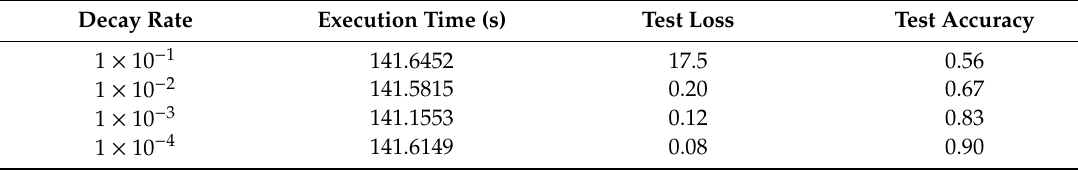
Table 22. E ff ect of learning rate decay on SNN.